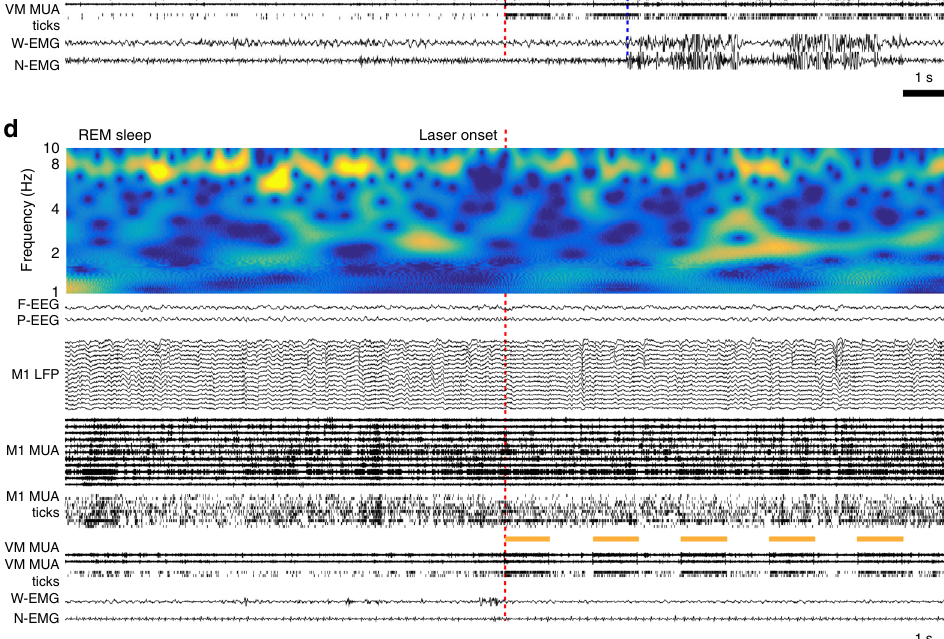
Fig. 2 Fast C1V1-mediated optogenetic stimulation of VM neurons awakens mice from NREM sleep but not from REM sleep. a Coronal section of the mouse brain (Bregma − 1.46 A/P) showing a representative example of virus expression in VM (DIO-C1V1-AAV5, green). Scale bar = 0.5 mm. b Example of awakening after laser stimulation of VM in NREM sleep, showing the 10 s before and after laser onset. Top; EEG power in the SWA (0.5 – 4.5 Hz) and theta (6 – 10 Hz) range decreases a few seconds after laser onset. Red open squares identify OFF periods. Yellow bars indicate laser pulses ( fi ve 1-s-laser pulses, spaced 1 s apart), which strongly drive VM unit fi ring (VM MUA and ticks, thresholded spikes). The blue dotted line indicates the time of manually scored awakening. c Cumulative distribution function (CDF) plots of automatically detected latency to awakening after VM stimulation in NREM and REM sleep in C1V1-VM mice. NS; p > 0.05, ** p < 0.01, yellow light stimulation vs. negative control in C1V1-VM, paired t -test ( n = 4 mice); * p < 0.05, yellow light stimulation in C1V1-VM vs. control mice, ks-test, using mean of each mouse ( n = 4 mice/group). d Example of VM stimulation in REM